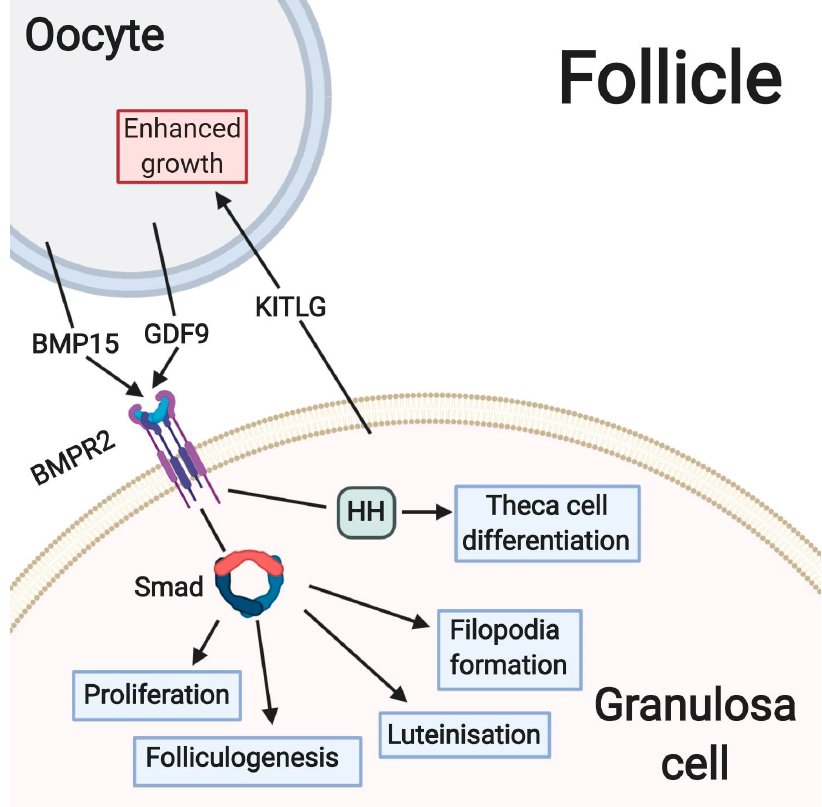
Figure 2. Oocyte-specific growth factors in folliculogenesis.